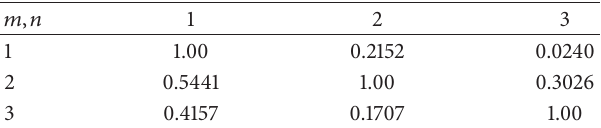
Table 5: Correlation matrix for OHT (lower/upper triangular part: amplitude/phase).